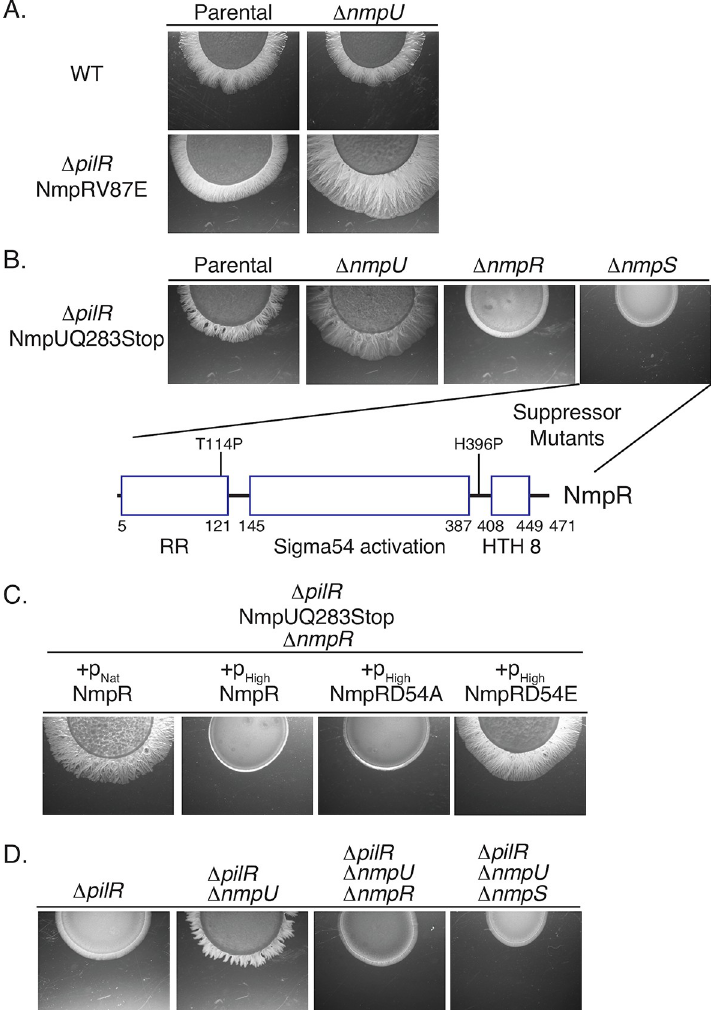
Fig 5. SK NmpU, RR-SK NmpS, and RR NmpR are in a single signaling pathway. Epistasis analysis demonstrates these signaling proteins are in a shared pathway. Mutations in various strains were constructed as depicted and motility assayed as before. Note especially that deletion of nmpR or nmpS is epistatic to a deleted or non-functional nmpU (B and D); that suppressor mutations in nmpR arose in the NmpUQ283Stop Δ nmpS strain (B and Fig 4); and that deletion of nmpU is sufficient to restore motility in the Δ pilR parental strain (D). As before, over-expression of a phosphomimetic (D54E) NmpR is necessary to restore motility of a Δ nmpR strain (C). The motility image of the parental NmpRV87E strain (A) is a representative image reproduced from Fig 3A. whether the hybrid sensor kinase NmpS also plays a role in a signaling pathway that includes SK NmpU and RR NmpR. Returning to our epistasis analysis, deletion of nmpS in the NmpUQ283Stop returned it to a non-motile state (Fig 5B and 5C). Therefore, Δ nmpS is also epistatic to the suppressor mutation of nmpU and is in a signaling pathway that includes the NmpU and NmpR. Remarkably, in the non-motile NmpUQ283Stop Δ nmpS strain (Fig 5B), additional suppressor mutants developed and when sequenced were once again identified in nmpR , indicating that NmpR is the output of this multi-component signaling pathway. Activa- tion of NmpR is sufficient to restore motility regardless of the loss of activity of the SKs NmpU or NmpS. Finally, epistasis analysis described here was recapitulated in the parental Δ pilR